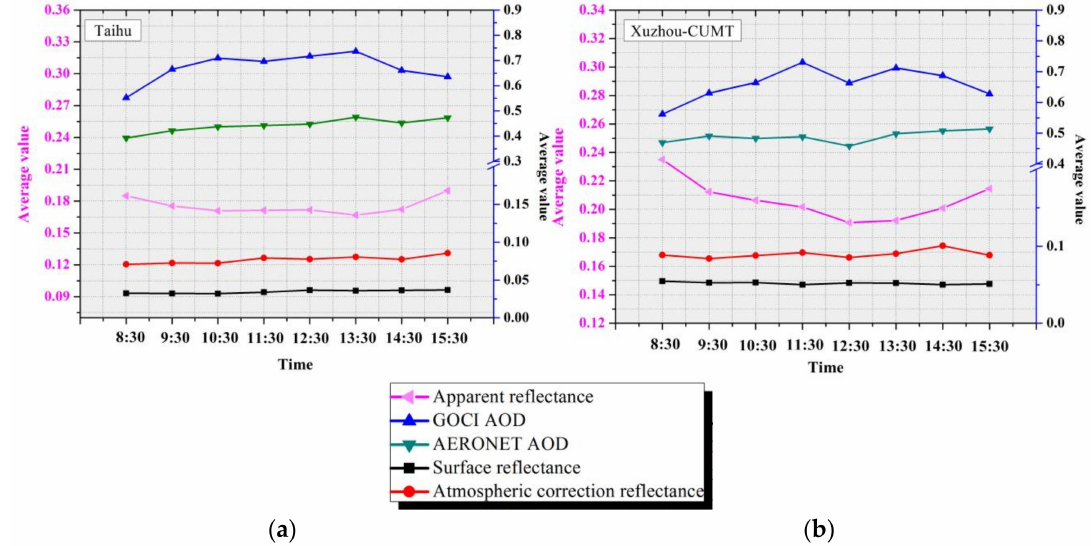
Figure 9. The influence of geometric conditions on retrieval of GOCI AOD (The ordinate of the apparent reflectance is the value on the left, and the ordinate of the other four curves are the value on the right); ( a ) Taihu, ( b )